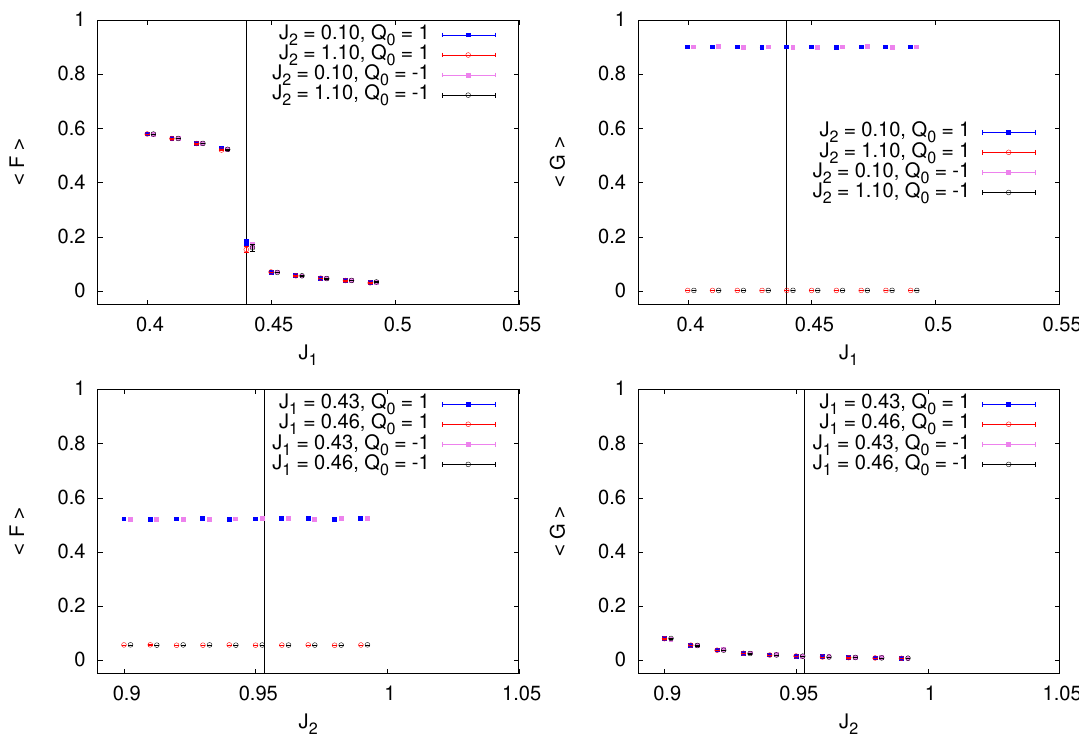
Figure 2 . Dependence of the plaquette and cube observables on J 1 (upper row) and J 2 (lower row) coupling constants. As predicted by the factorization theorem, h G i does not depend on J 1 (upper right panel), whereas h F i does not depend on J (lower left panel). h F i show a significant 2 jump around the expected first order phase transition marked by the solid vertical black line on the upper, right panel. As far as h G i is concerned, lower right panel shows a rather smooth dependence and no significant signs of the expected second order phase transition marked again by the solid vertical line. Figure 3 demonstrates that indeed a second order phase transition happens around the expected J crit . In all the cases, results from both topological sectors are shown: Q = 1 and 0 2 Q 0 = − 1 , with Q µ = 1 for µ 6 = 0 . The data points for the latter are shifted by 0 . 0025 along the x -axis in order to increase the plot